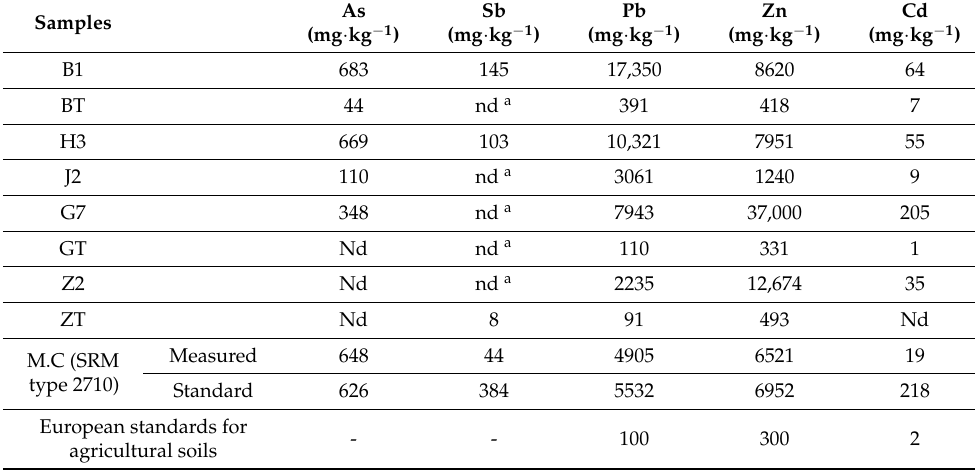
Table 5. Total PTE concentrations in the studied soils (M.C: soil reference